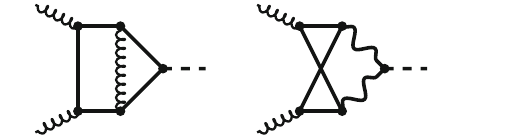
Fig. 6 Representative two-loop planar (left) and non-planar (right) triangle diagrams. Solid and wavy lines correspond to massive propagators with different masses; wavy lines correspond to massless